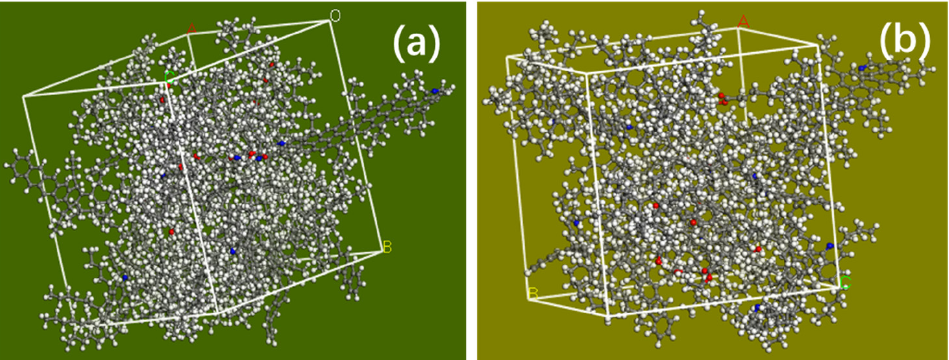
Figure 15. Molecular models of virgin asphalt ( a ) and aged asphalt ( b ) containing 3% sunflower oil.